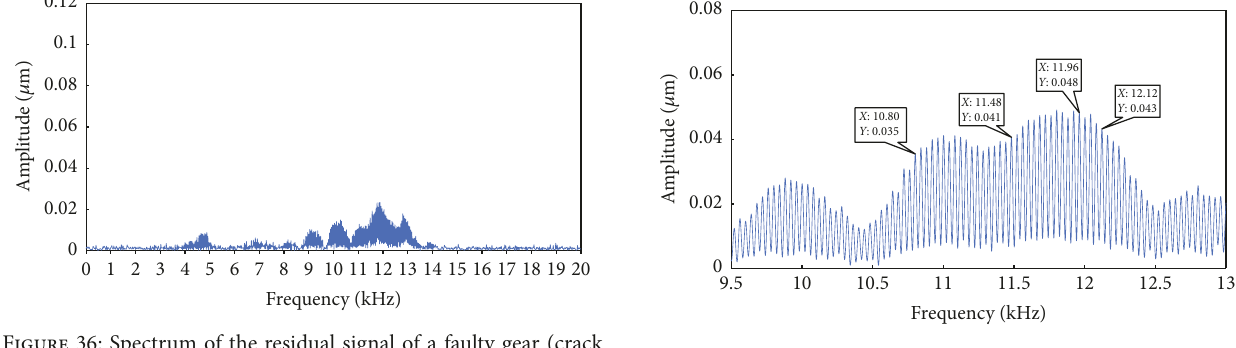
Figure 39: Close-up view of Figure 38 showing the multiple integers of the pinion rotational speed (40 Hz).